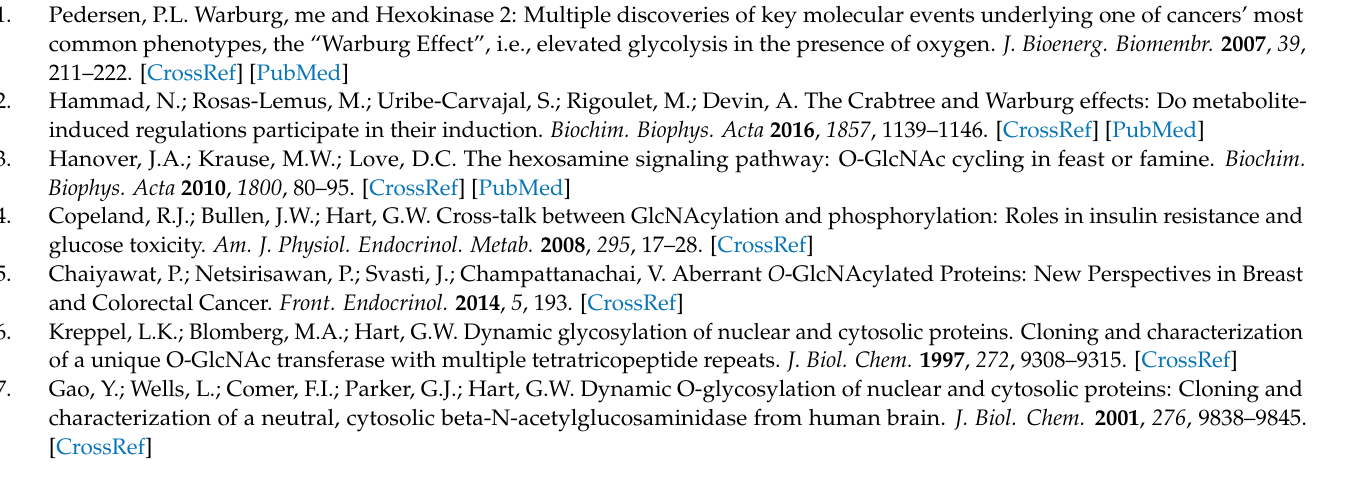
Table S3: Both method per cell line, Table S4: Gold list, Table S5: Nuclear candidates, Table S6: All mitochondrial Candidates, File S1. The original western blot figures, File S2: Supplementary methods, Figure S1: Densytometric analysis of O-GlcNac levels in mitochondria-enriched fraction from Western blots presented on Figure 2B, Figure S2: mOGT up-regulation alter cellular respiration and glycolytic activity, Figure S3: Intracellular and mitochondrial calcium levels in breast cancer cells with up- regulated mOGT, Figure S4: mOGT treated cells lose the viability and change their cell